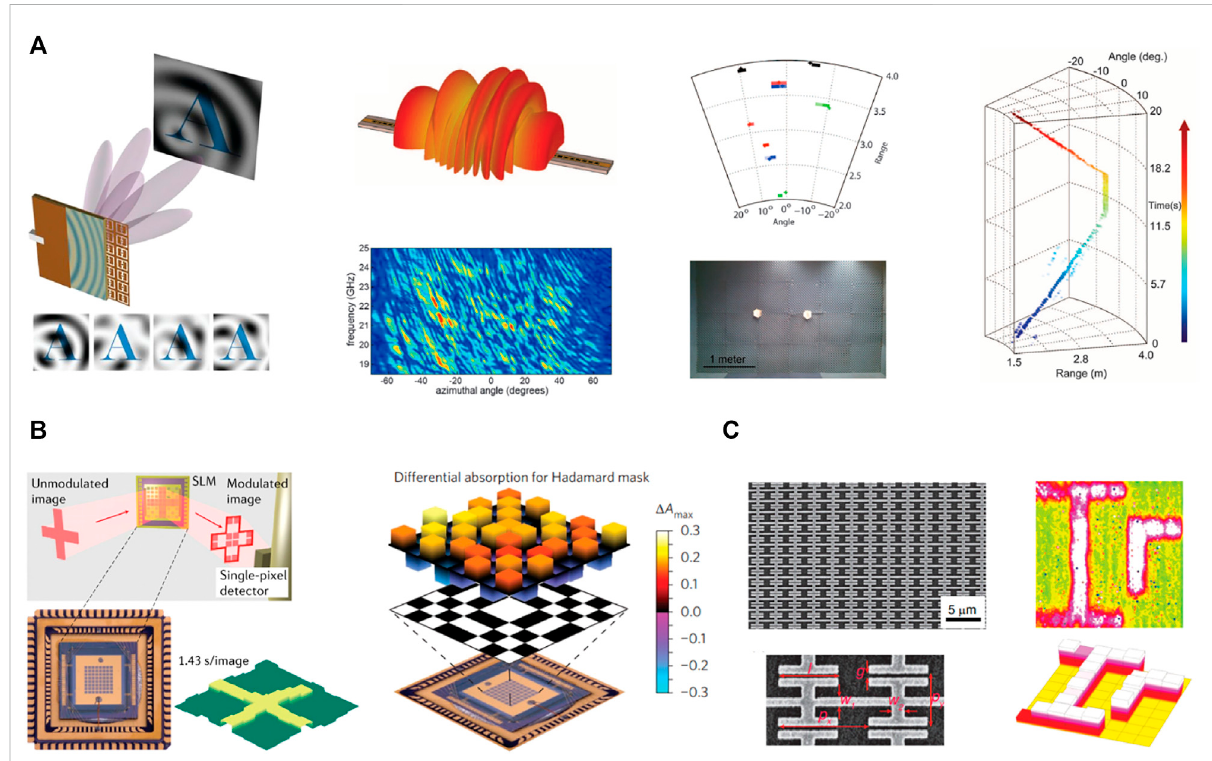
FIGURE 4 Single-pixel imaging with metamaterials. (A) Metamaterial apertures for computational imaging with microwaves [104]. (B) Terahertz compressive imaging with metamaterial spatial light modulators [105]. (C) Graphene metamaterial spatial light modulator for infrared single-pixel imaging [106]. Figure reproduced with permission from: (A) , © 2013, American Association for the Advancement of Science; (B) , © 2014, Nature Publishing Group; (C) , © 2017, Optical Society of